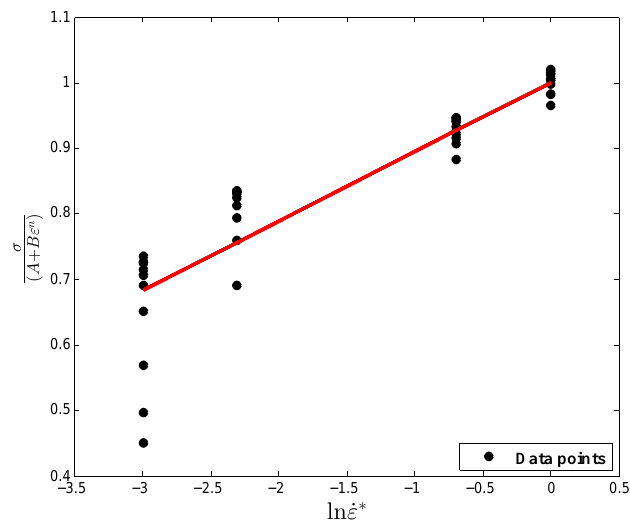
Figure 4. Relationship between σ